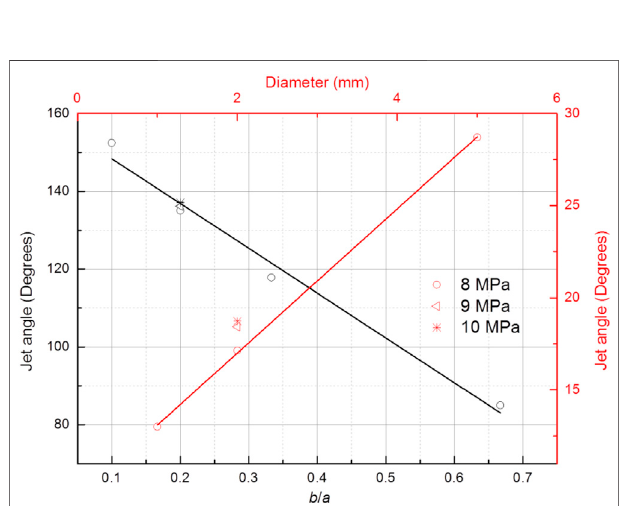
FIGURE 7 | Correlation between characteristic parameters (b/a and d) and θ max.